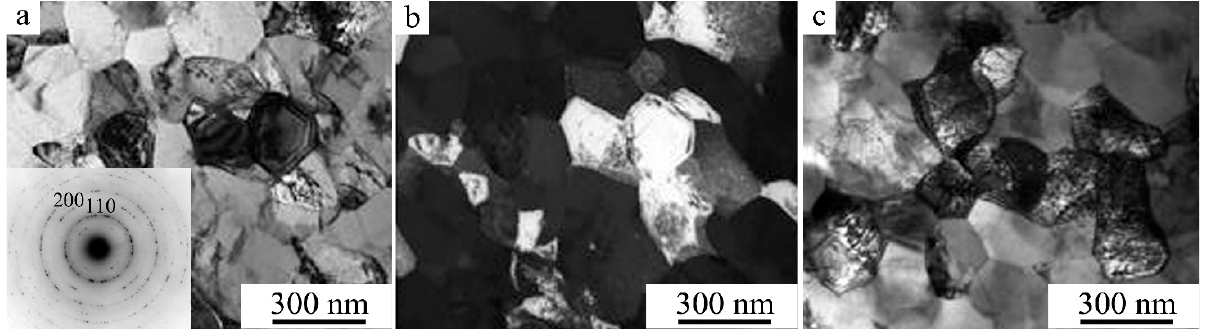
Figure 5. ( a , c ) Bright- and ( b ) dark-field TEM images of the B 2 austenite microstructure of UFG Ti 49.4 Ni 50.6 alloy obtained by ECAP at 723 K, 8 passes and ( a ) the corresponding ring-wise SAED pattern (SD 1.0 µm). ( a , b ) are transverse cross sections and ( c ) is a longitudinal cross section.